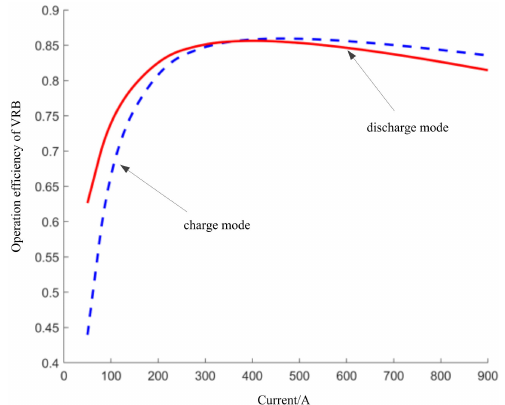
Figure 9. Current–efficiency curve of